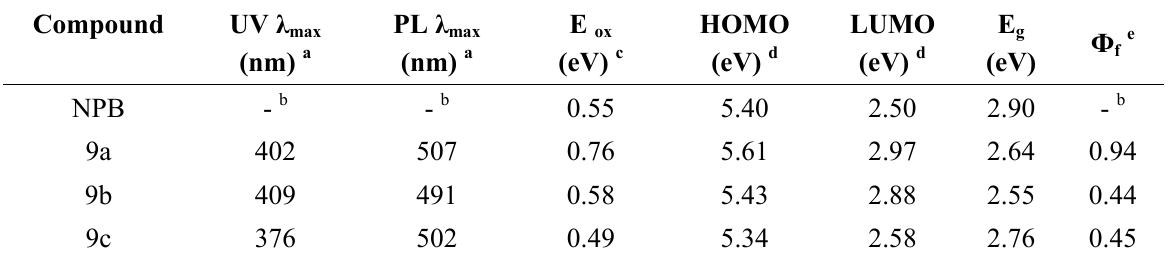
Table 1. Photophysical properties of green dopants 9